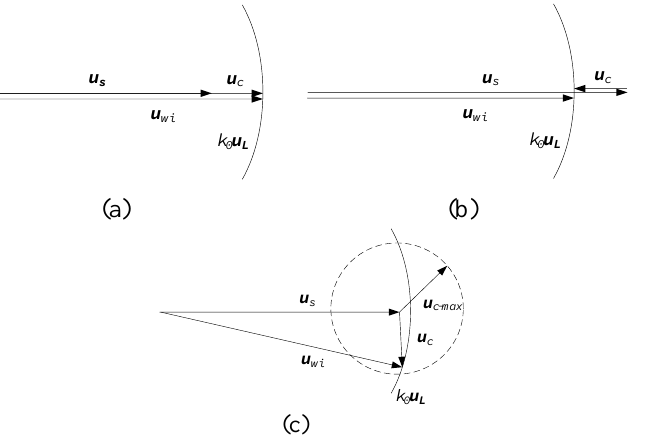
Figure 2. Voltage vector relationship of Flexible OLVR ( a ) The same direction compensation scheme ( b ) The reverse direction compensation scheme ( c ) Arbitrary direction compensation scheme.